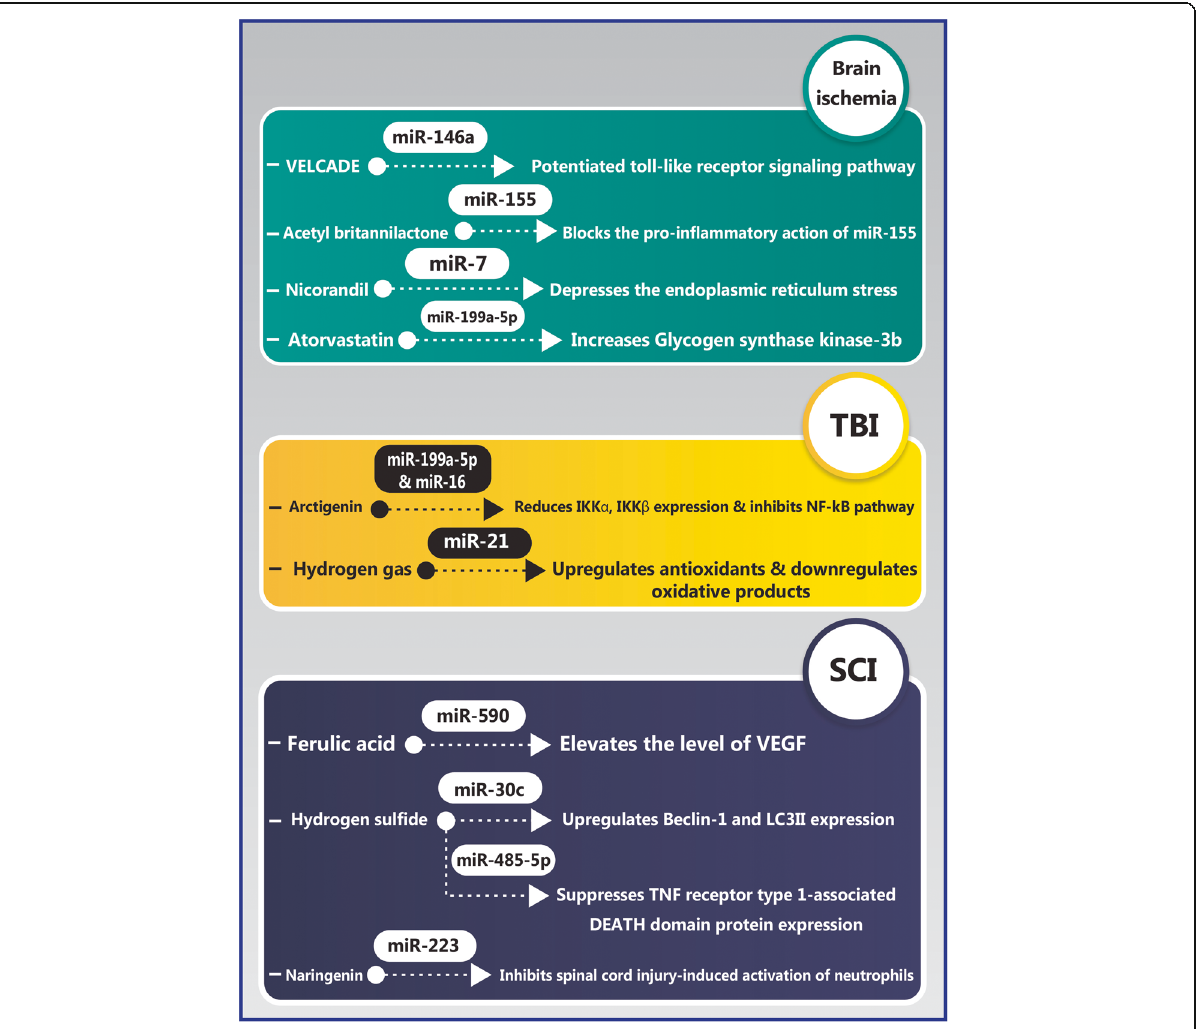
Fig. 6 Micro RNAs-based therapeutics in different neurological disorders. Some pharmacological agents can exert neuroprotection through the regulation of functional miRNAs in ischemic stroke, traumatic brain injury, and spinal cord injury. TBI: traumatic brain injury, NF- Κ b: nuclear factor kappa B, SCI: spinal cord injury, VEGF: vascular endothelial growth factor, TNF: tumor necrosis